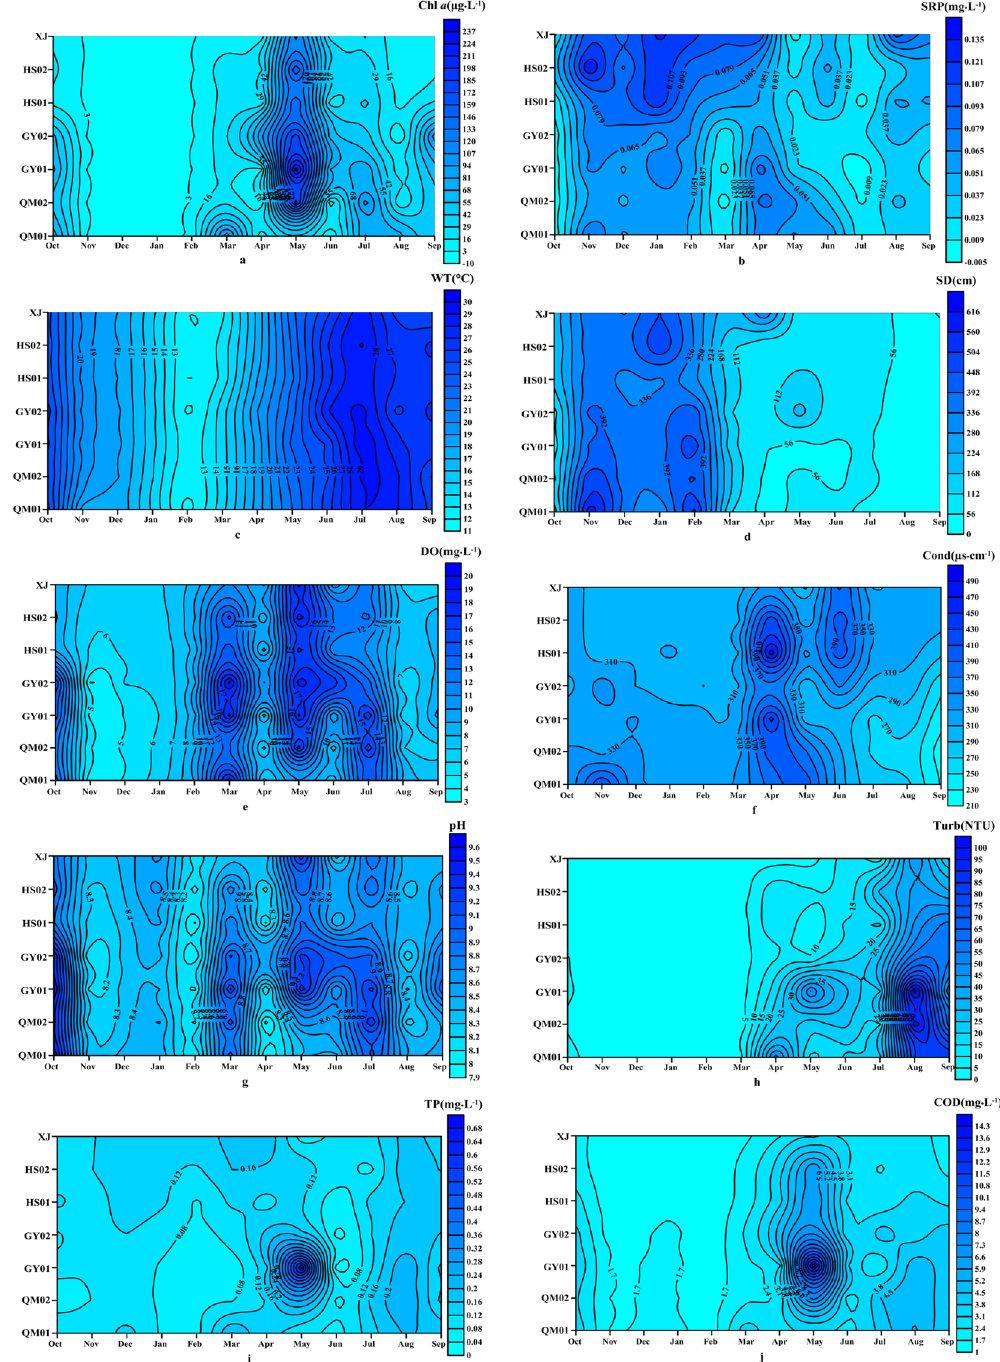
Figure 4. Temporal and spatial variations of a: chlorophyll ( a ) (Chl a ) and other environmental parameters. ( b ) Soluble reactive phosphorus (SRP); ( c ) water temperature (WT); ( d ) transparency (SD); ( e ) dissolved oxygen (DO); ( f ) conductivity (Cond); ( g ) pH; ( h ) turbidity (Turb); ( i ) total phosphorus (TP) and ( j ) chemical oxygen demand